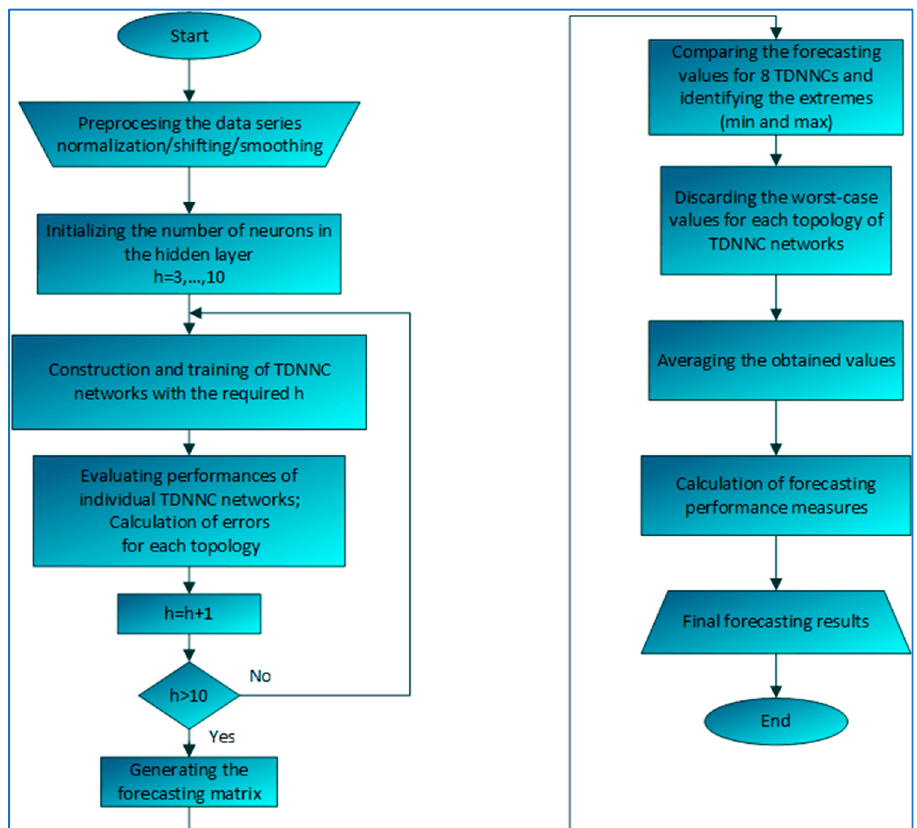
Figure 4. Optimal Time Delay Neural Network based Algorithm for Short-Term Prediction.